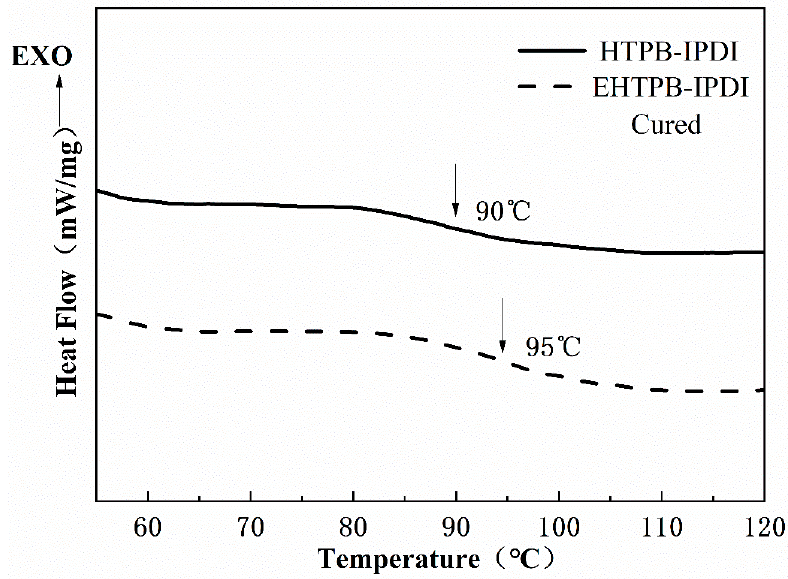
Figure 8. Glass transition temperature ( T g ) determined by the DSC thermograms at a scanning rate of 10 °C min − 1 for the EHTPB-IPDI and HTPB-IPDI systems.